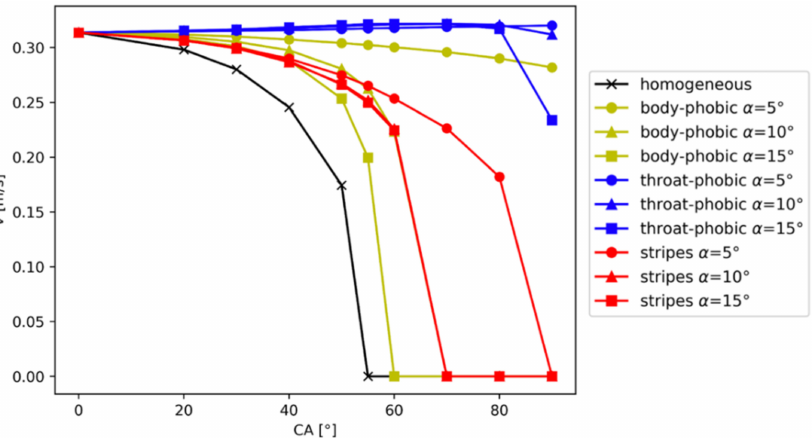
Figure 16. v as a function of CA for homogeneous, body-phobic, throat-phobic and stripes coating pattern. The CA is related to the compartments of the particle surface whose wettability is